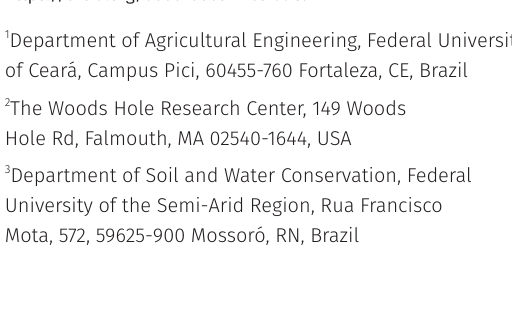
Figure S5. Scatter plot of field and satellite estimates of biomass averaged by physiognomy as defined in field data base (Table SI). The numbers of ground data points in each physiognomy is presented, the extension of the ellipses indicate the standard deviation of the series of AGB to the corresponding